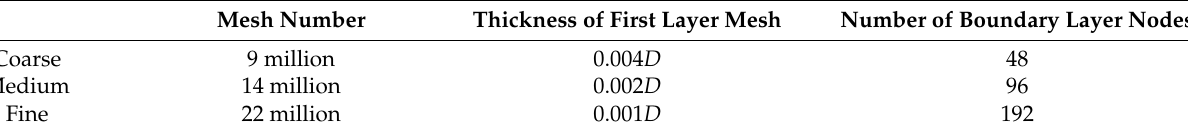
Table 2. Coarse, medium, and fine mesh used for mesh convergence analysis.